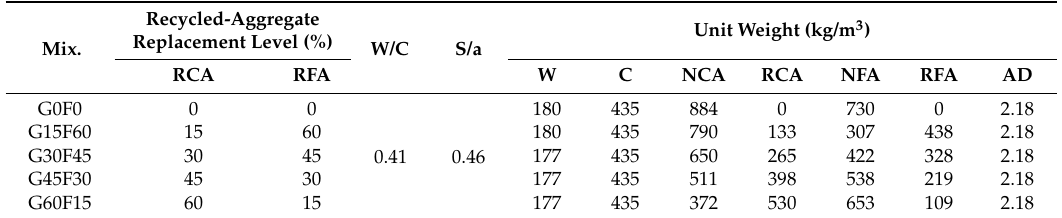
Table 2. Mix proportions of concrete